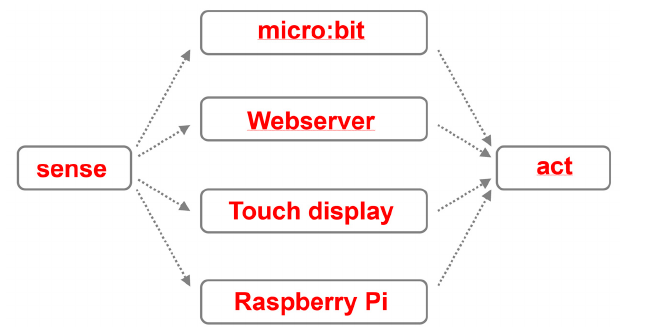
Figure 6. The behavior-based robotics approach is used as inspiration for control of the GrowBot. The suppression method allows a higher level to suppress any lower level in a priority-based coordination.